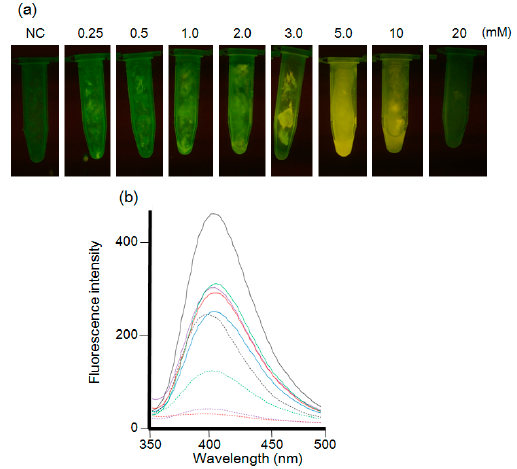
Figure 3. ( a ) F. oxysporum after the treatment of various concentrations of CdCl 2 and Na 2 SeO 3 solutions observed under the UV light (wavelength: 365 nm). The concentration ratio between CdCl 2 and Na 2 SeO 3 kept 1:1. NC: Negative control without treatment of cadmium and selenium solution. From the left side, each tube indicated 0.25, 0.5, 1, 2, 3, 5, 10 and 20 mM solutions, respectively; ( b ) The fluorescence spectra (excitation at 310 nm) of extracts from the mycelial cells in each condition using ultrasonication. Black line: 5 mM. Green line: 2 mM. Red line: 0.5 mM. Purple line: 0.25 mM. Blue line: 1 mM. Black broken line: 3 mM. Green broken line: 10 mM. Purple broken line: 20 mM. Red broken line: negative control.